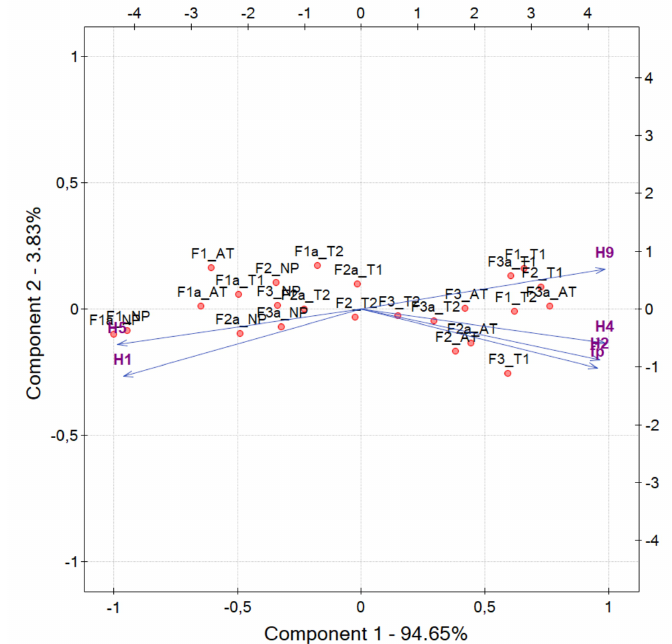
Figure 10. Score plot of strongly correlated textural features in L P layer of OCT images cast on the plane of principal components PC 1, PC 2 for different fabric abrasion tests. In addition to the original textile samples, fabrics subjected to laser ablation were also used for PCA analysis, marked in the plot with the suffix a. ( H 1 , H 2 , H 4 , H 5 , H 9 , f P )—coordinates of the original feature space. F 1, F 2, F 3—tested